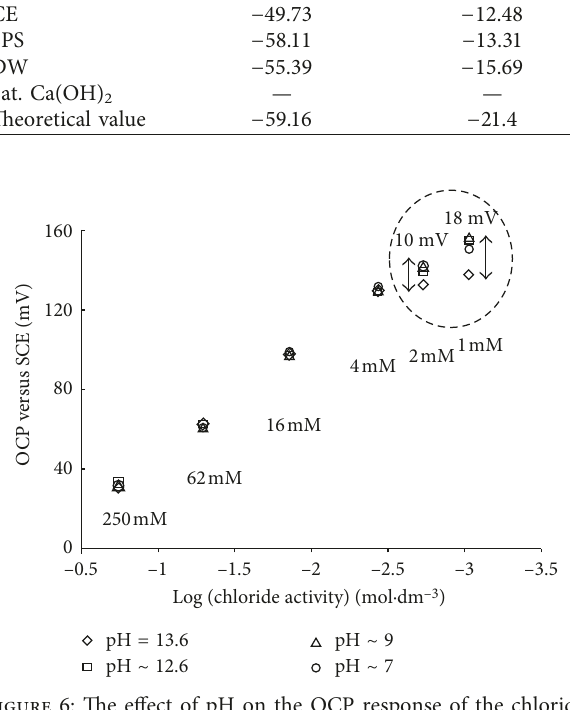
Figure 6: The effect of pH on the OCP response of the chloride sensor.